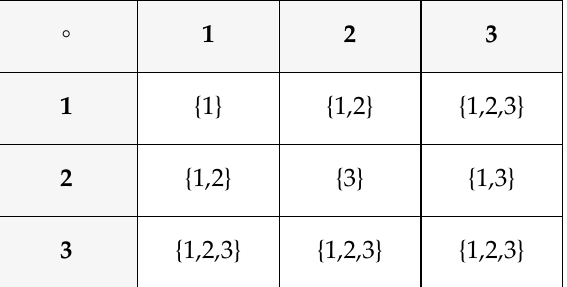
Table 12. A LA- and RA-hypergroup.